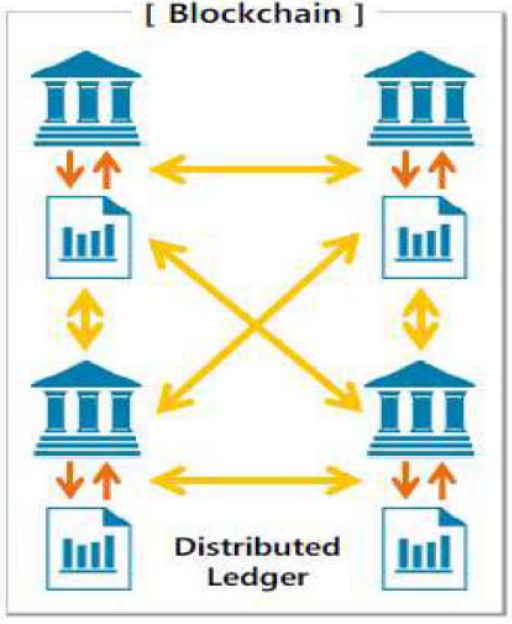
Figure 2. Diagram of Blockchain.